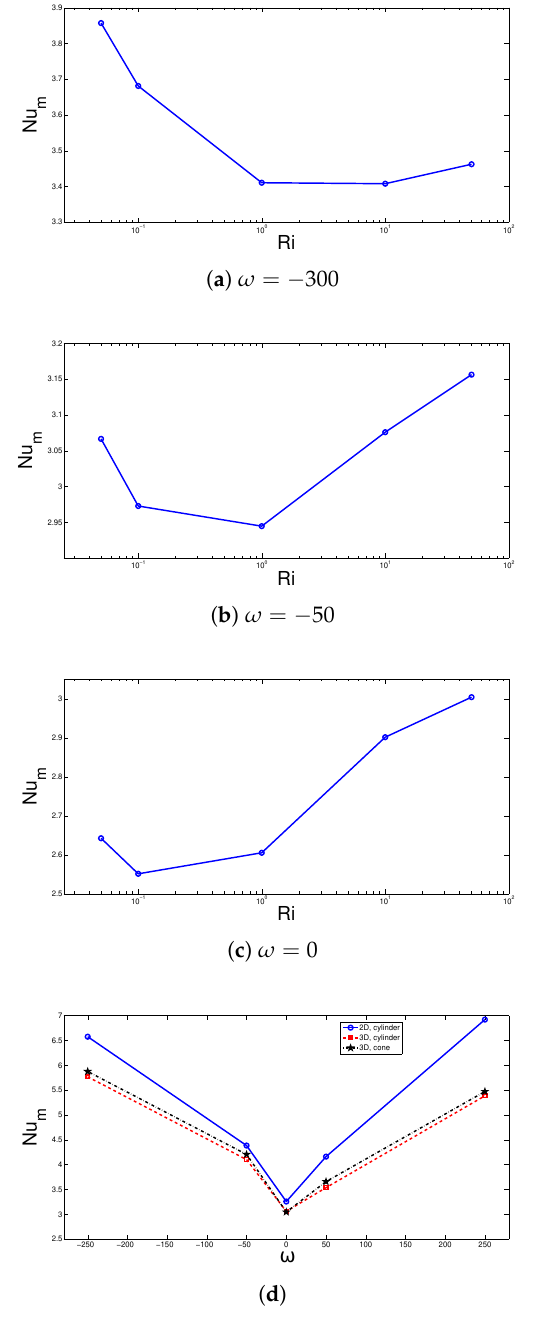
Figure 5. The average Nusselt number versus Richardson number variations for different angular rotational speeds ( a – c ) (Ha = 10, Da = 10 − 3 , AR = 0.25, x 0 = 0.5 H, φ = 0.04) and variation of average Nusselt number with respect to changes in ω for 2D circular cylinder, 3D circular cylinder and 3D circular cone (AR = 2) configurations ( d ) (Ha = 10, Da = 10 − 3 , ω = − 100, x 0 = 0.5 H, φ =